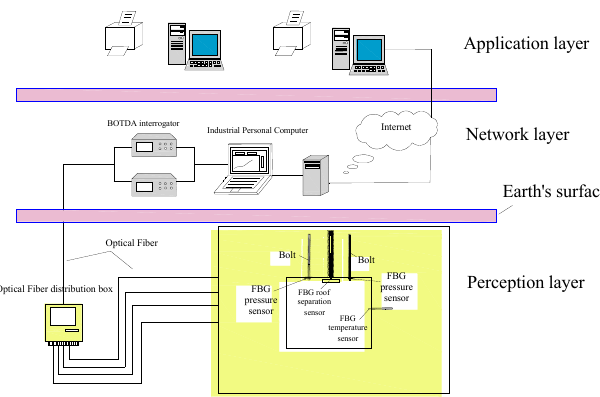
Figure 2. Framework of the FBG-based monitoring system.